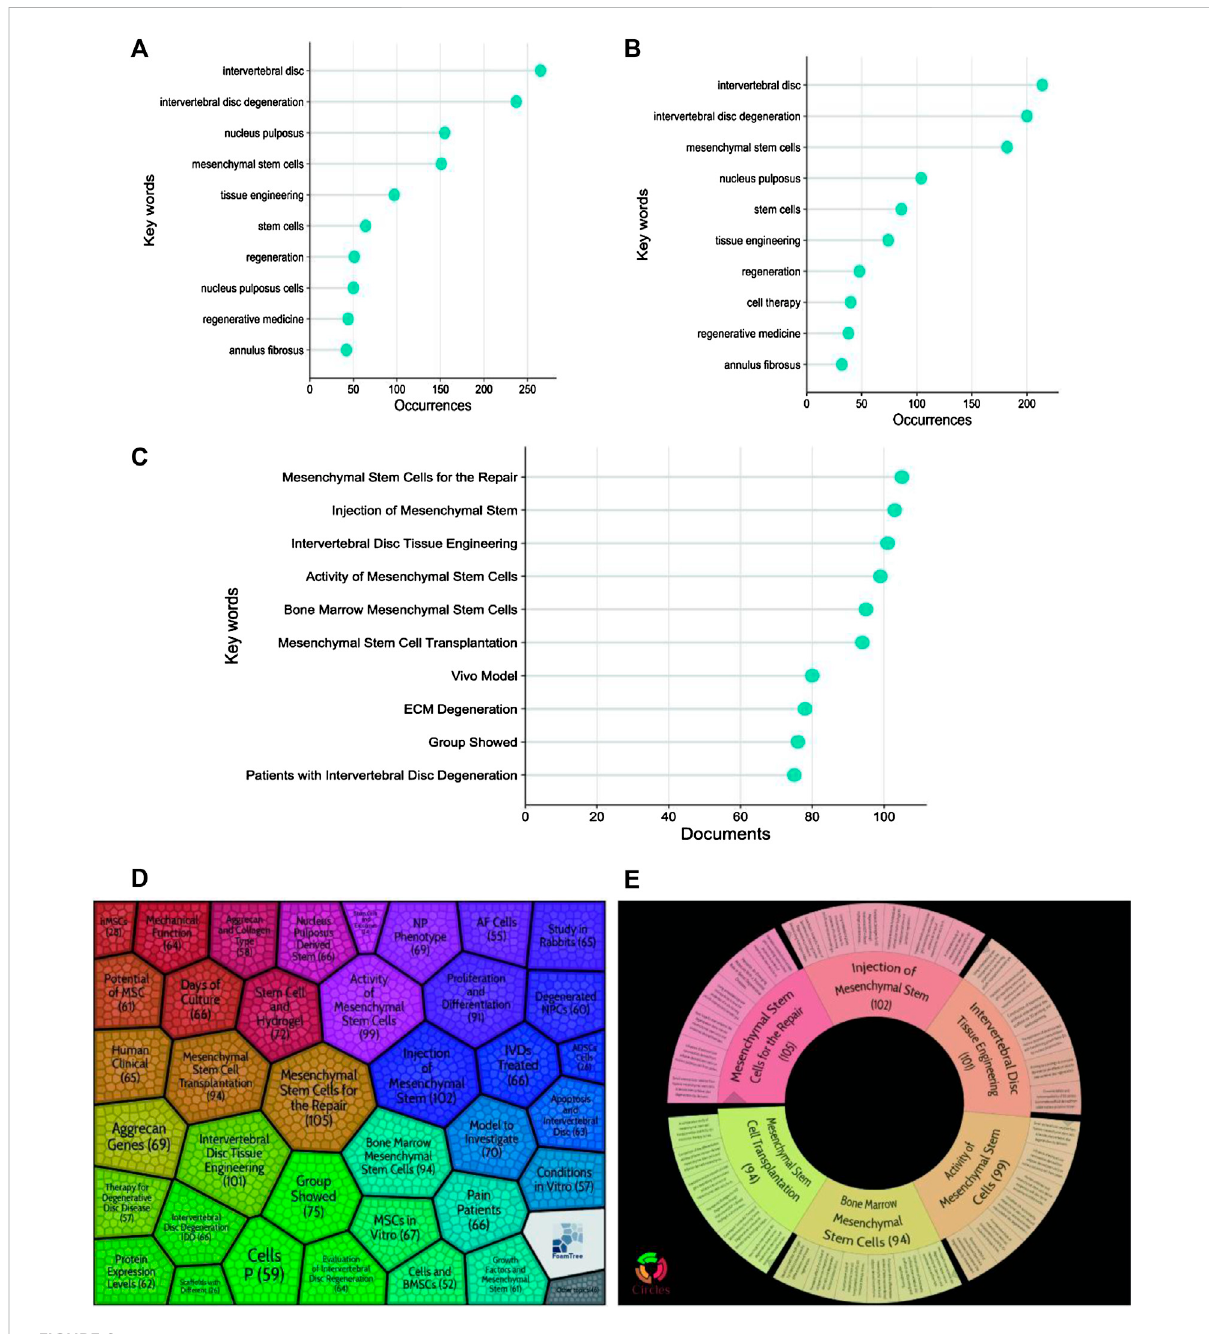
FIGURE 9 Keywordoccurrencefrequencystatistics. (A) :Top10keywordslollipopchartinWOSCC; (B) :Top10keywordslollipopchartinScoups; (C) :Top 10 topics lollipop chart in Pubmed; (D) : Main topics treemap using Carrot2; (E) : Main topics pie-chart using Carrot2.